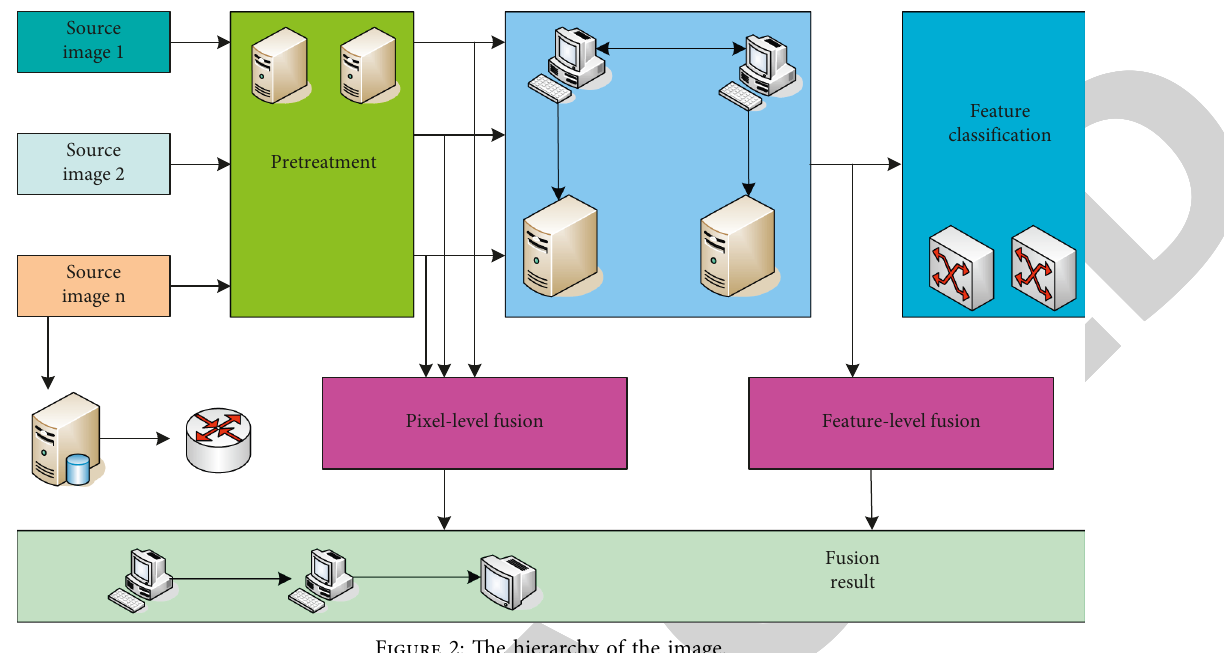
Figure 2: The hierarchy of the